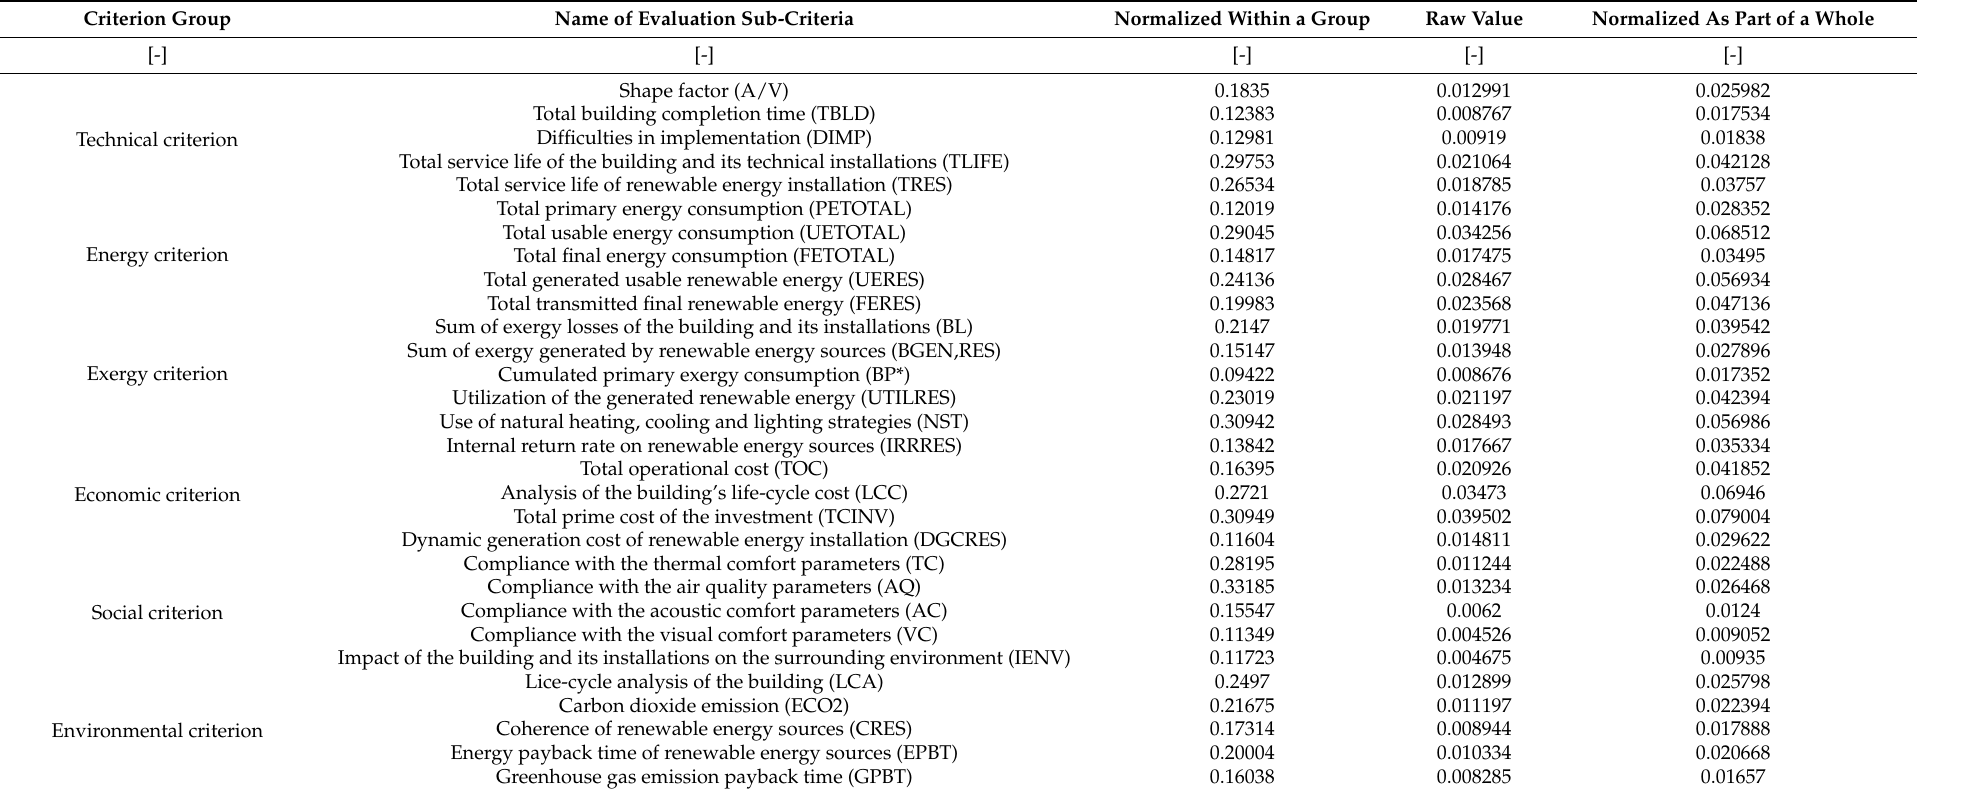
Table 4. Weight vectors for all sub-criteria of evaluation, all